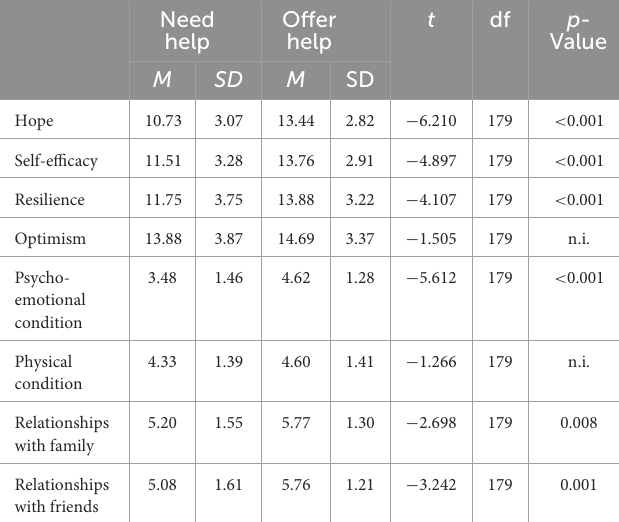
TABLE 5 Descriptive statistics of people needing help and offering